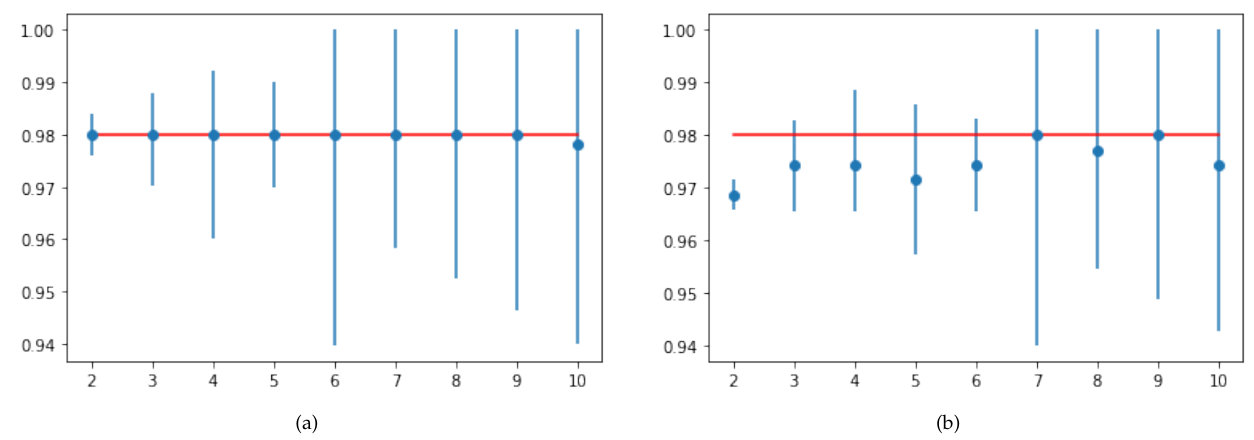
Figure 8. Plot for foldwise score: ( a ) support vector machine; ( b ) random forest.